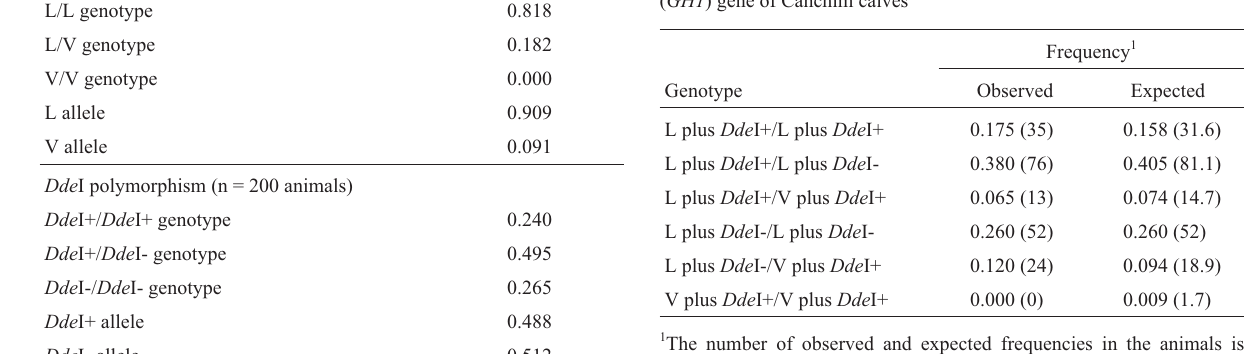
Table 3 - Observed and expected frequencies of each genotype in Can- chim cattle considering the combined distribution of the Alu I and Dde I polymorphisms in the amplified fragments of the growth hormone 1 gene ( GH1 ) gene of Canchim